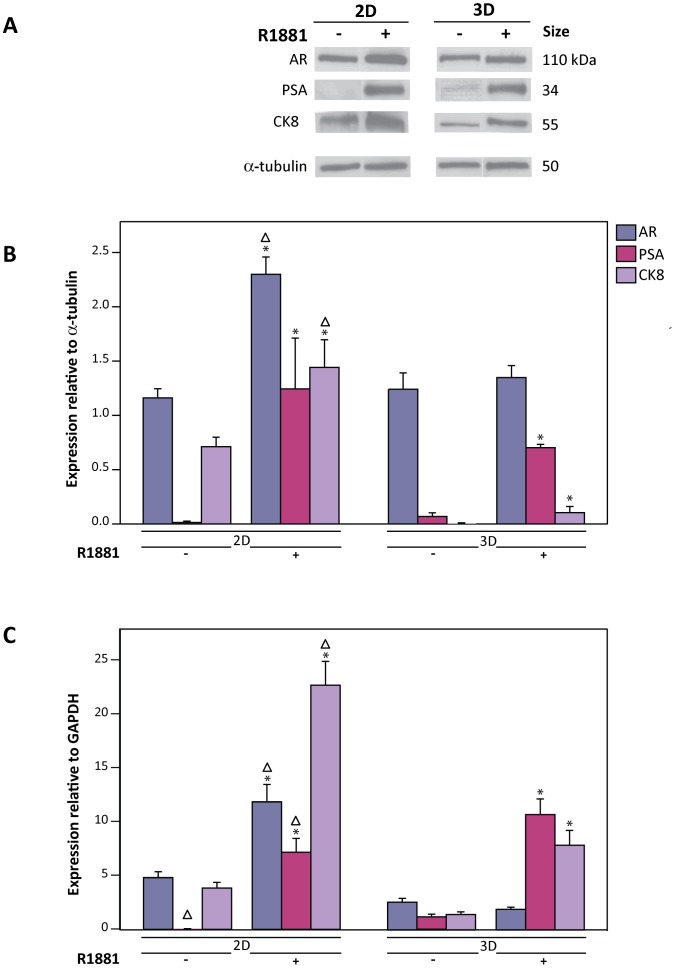
Protein and mRNA levels of 2D and 3D cultures in response to 1 nM R1881 after 48 h of treatment.(A) A representative Western blot reveals an increased level of all the investigated proteins in 2D cultures when treated with R1881 compared to the non treated (ethanol controls) while in 3D cultures, only PSA and CK8 are significantly elevated. (B) Signal ratio of proteins relative to α-tubulin from Western blots of R1881 treated and ethanol control groups (−R1881) are presented as mean ± SE. The protein quantifications support the changes shown in immunoblots above. (C) qRT-PCR representing expression of LNCaP cell markers (mean ± SE) where PSA and CK8 are up-regulated at the mRNA level upon treatment in both 2D and 3D cultures when compared to non treated 2D or 3D groups. The AR is only elevated in 2D cultures. Significant difference (p<0.05) between treated and non-treated samples within similar groups (either 2D or 3D cultures) is denoted by (*) and between similar treatment of different groups are denoted by (Δ). Triplicate samples were analyzed from at least three independent experiments.